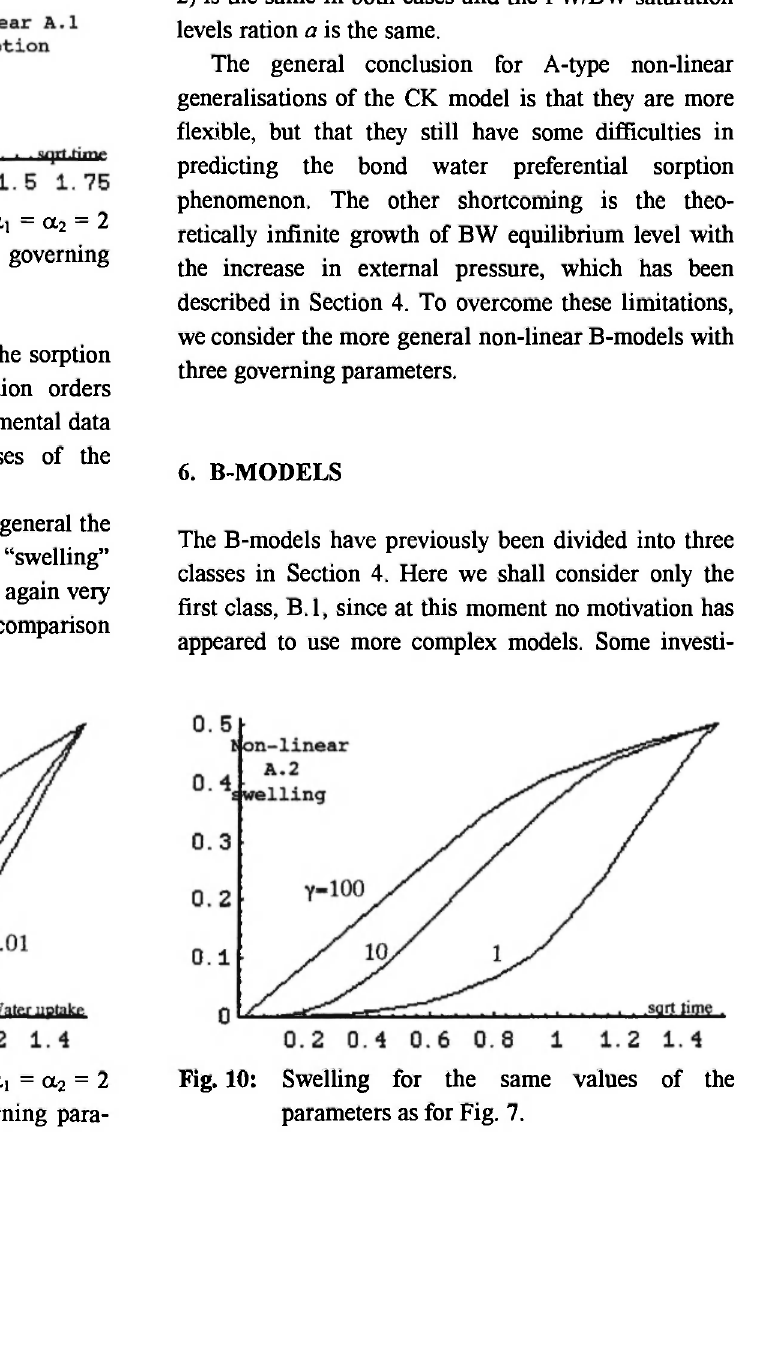
Fig. 9: The swelling for the A. 1 model, αϊ = α 2 = 2 and the same values of the governing para- meters as in Fig. 1.